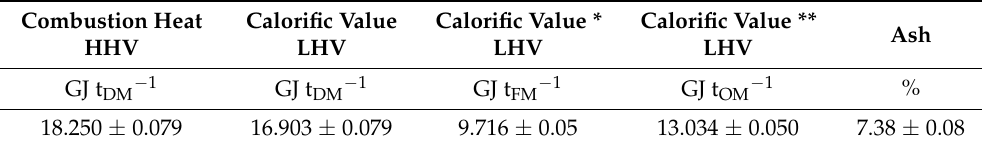
Table 4. Combustion heat and calorific values of reed related to the dry weight, fresh weight, and moisture required for the biomass furnace.